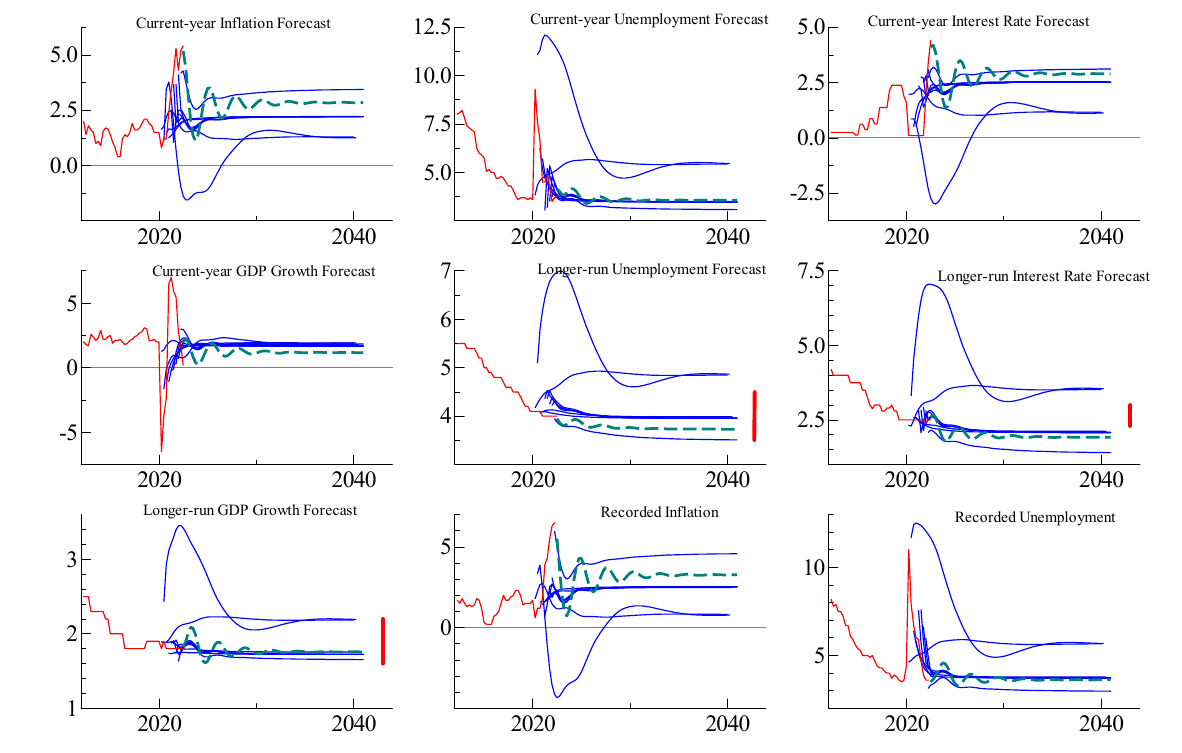
Figure A8. Sensitivity of simulations to estimation sample and starting value. Green dashed line represents the path based on the full estimation sample and 2022: Q2 as the initial condition for simulation. Vertical red segments represent the range of the FOMC longer-run forecasts. Each blue line represent the s-step ahead prediction associated with each starting date.